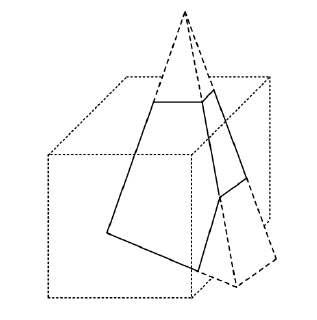
Figure 8. Implementation of three-dimensional viewing.